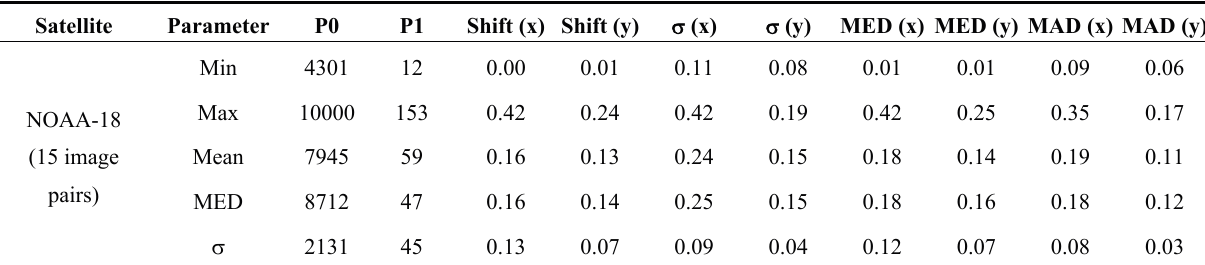
Table 8. BBR accuracy evaluation results between AVHRR Bands 2 and 3B; statistical summary from the point matching results of all NOAA-18 satellites. The given statistics are in pixels and are derived from the absolute values.